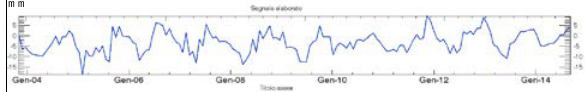
Figure 5. Residual curve of a point inside the storage field 5.2.3 Frequency component To find a periodic behaviour a computation of a frequency component is calculate with a Fast Fourier Transform algorithm. In the plot of Figure 6 occurrence of different